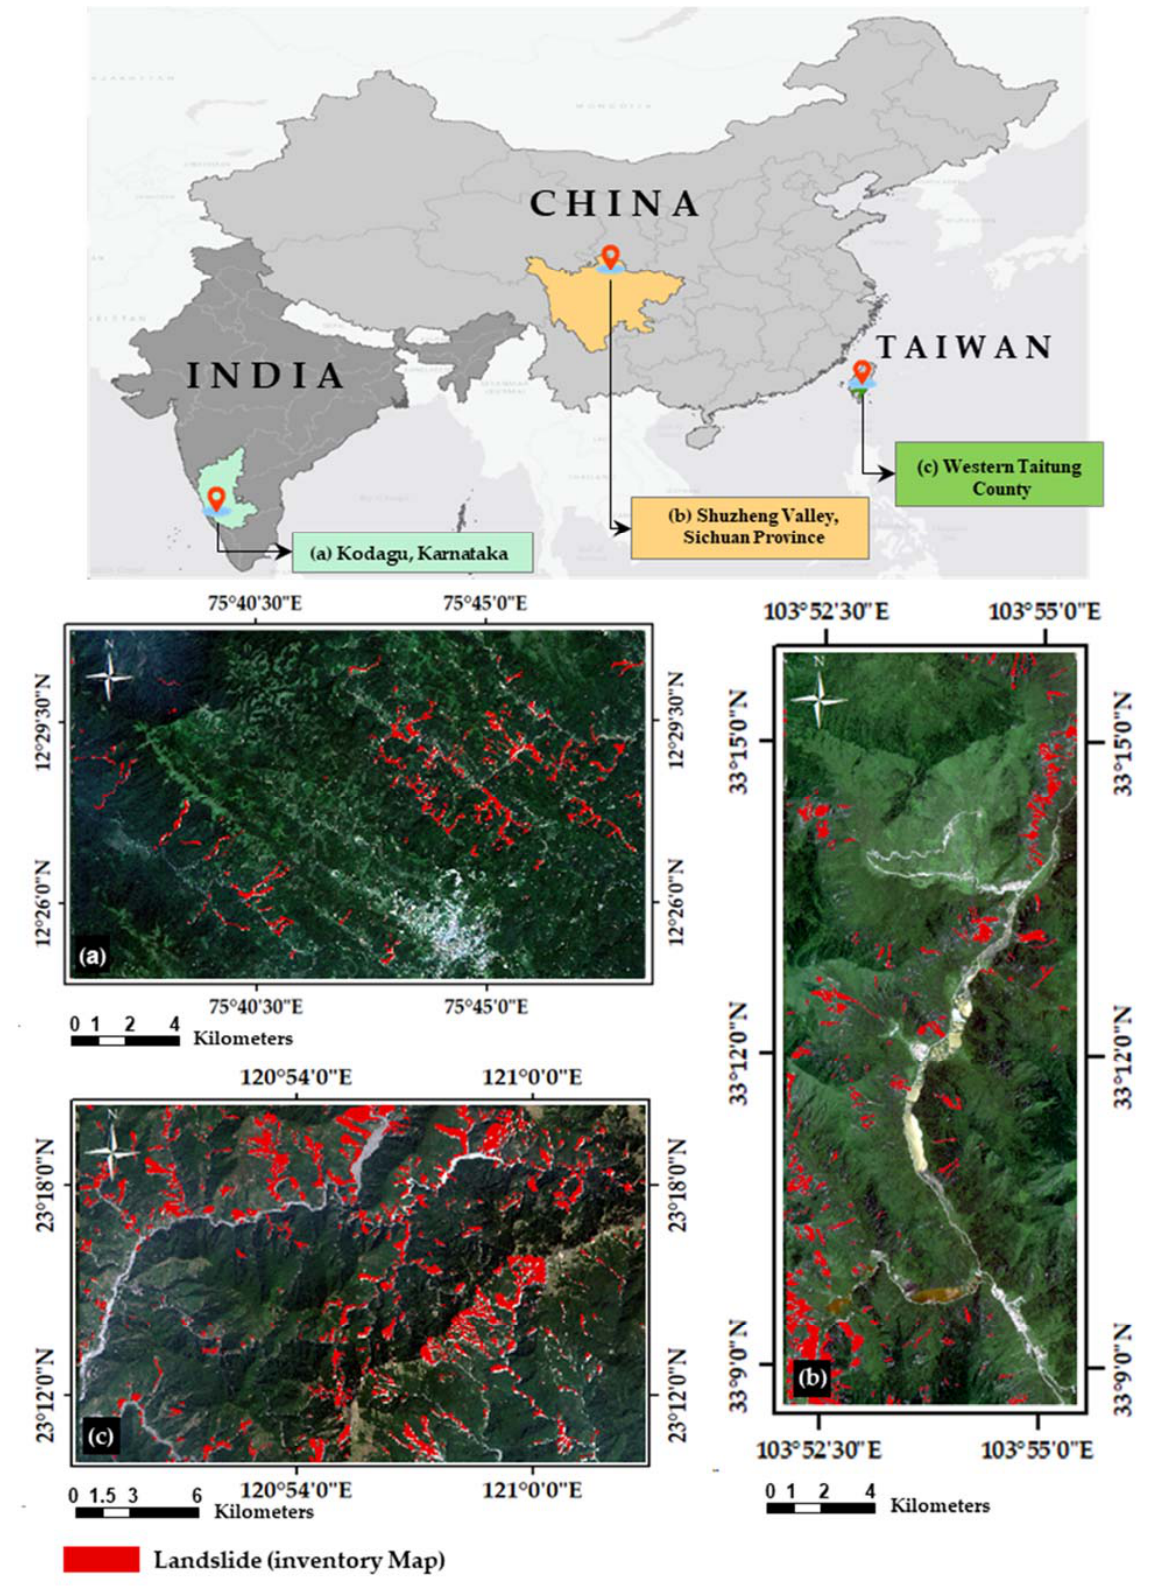
Figure 1. The geographical location of study areas and corresponding landslide inventory map. ( a ) India, ( b ) China, and ( c ) Taiwan. The background image for all three cases is the Sentinel-2 natural color composite.